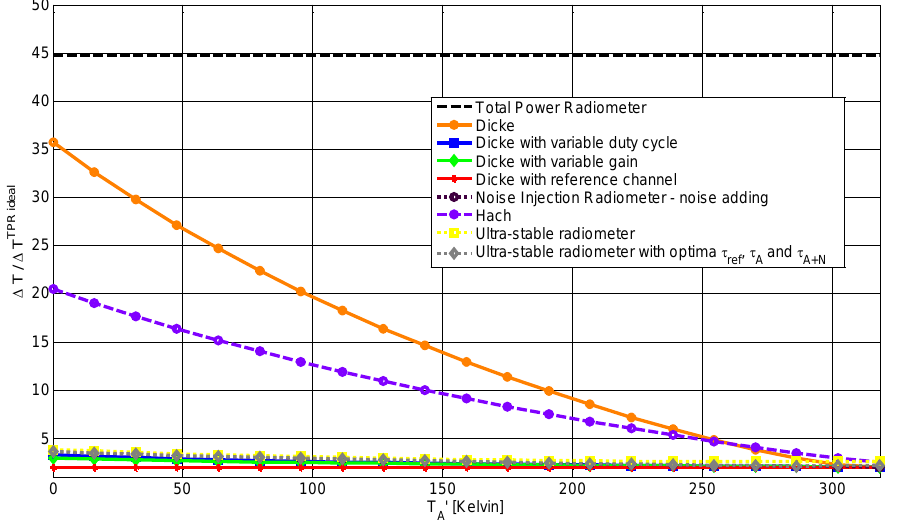
Total Power Radiometer Dicke Dicke with variable duty cycle Dicke with variable gain Dicke with reference channel Noise Injection Radiometer - noise adding Hach Ultra-stable radiometer Ultra-stable radiometer with optima 